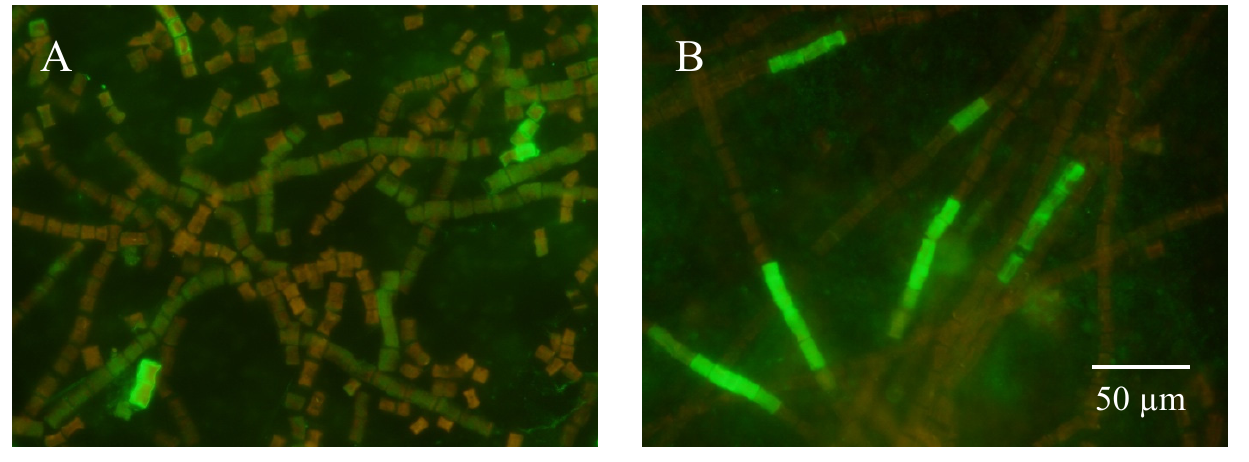
Figure 5. Immunofluorescent detection of nitrogenase in T. erythraeum cells . Binding of with the Qdot 525 anti-rabbit IgG antibody. T. erythraeum cells from a 35 day old culture (A) and from a 55 day old culture (B). Both images are captured at 1000X